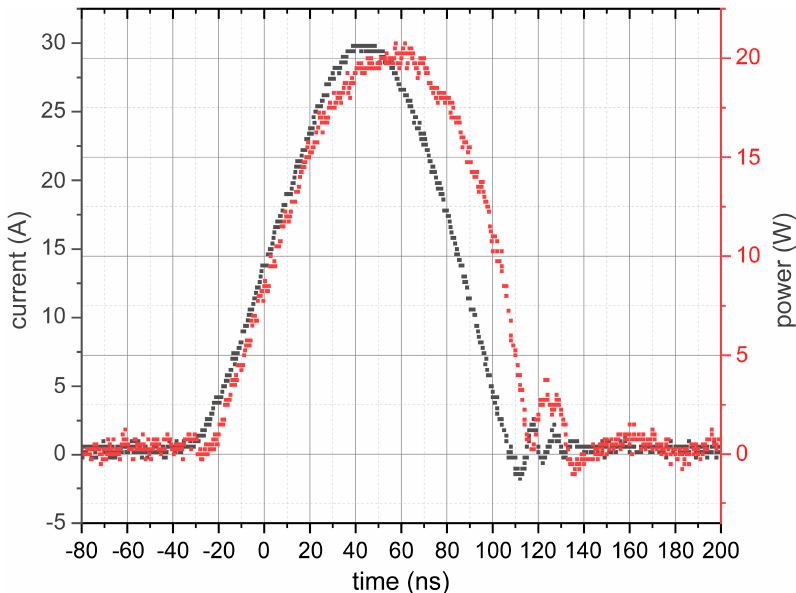
Figure 11. Measured current and optical power pulses.